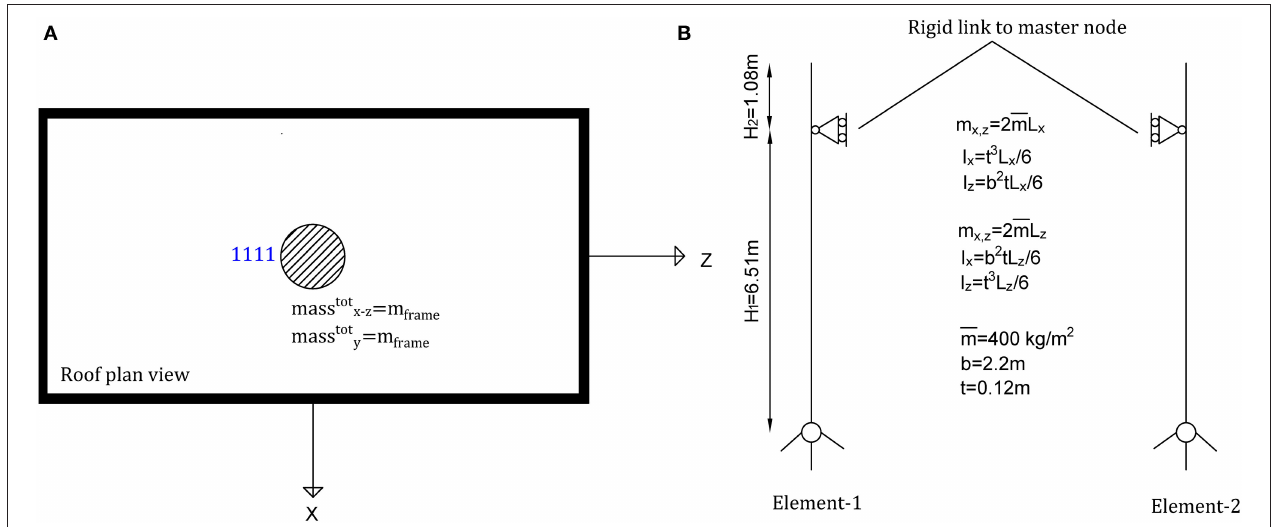
TABLE 2 | Fundamental periods calculated in each main direction: comparison with model results for both spread and lumped panel mass assumptions. Frame Only Spread Mass Theoretical Spread Mass